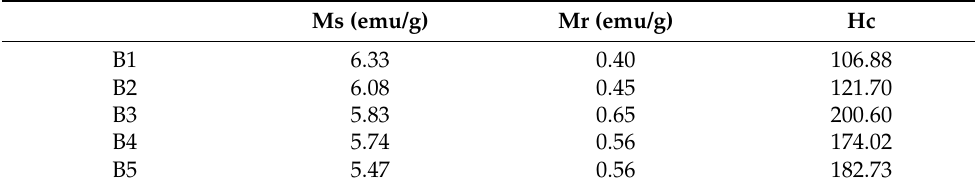
Figure 5. Hysteresis loops of the composite powders with different contents and the enlarged view as shown in the inset. Table 2. Magnetic parameters of the composite powder samples.